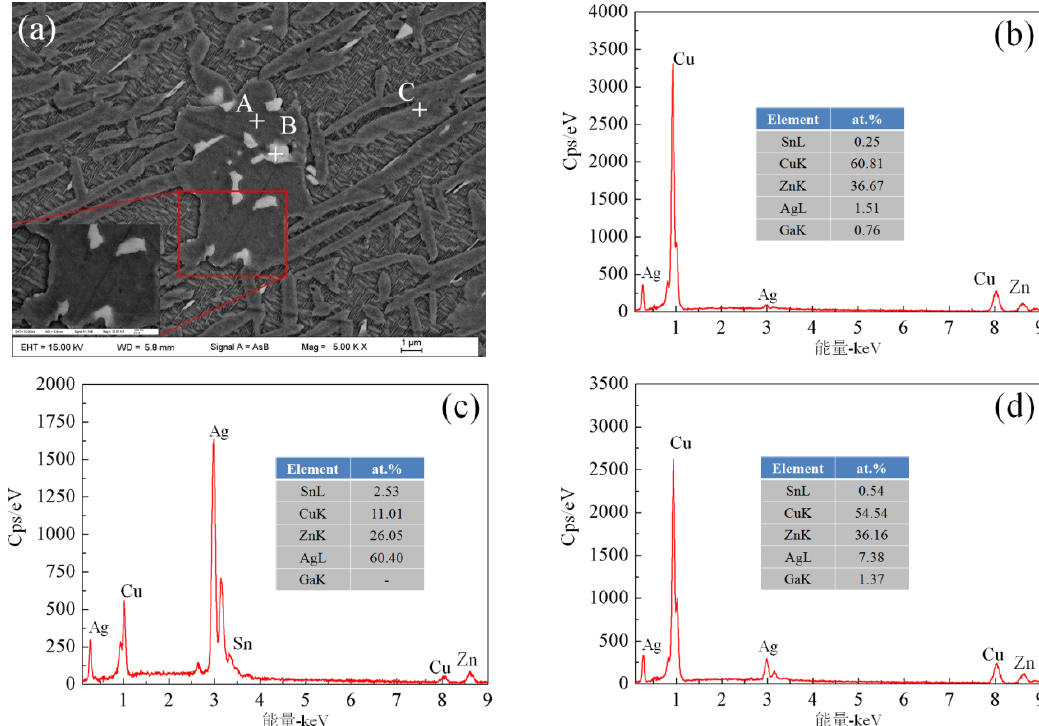
Figure 7. Microstructure of the Ag16.5CuZnSn-2Ga brazing seam after aging treatment for 600 h: ( a ) microstructure of Ag16.5CuZnSn-2Ga brazing seam, ( b ) EDX result of spot A, ( c ) spot B, ( d ) spot C.